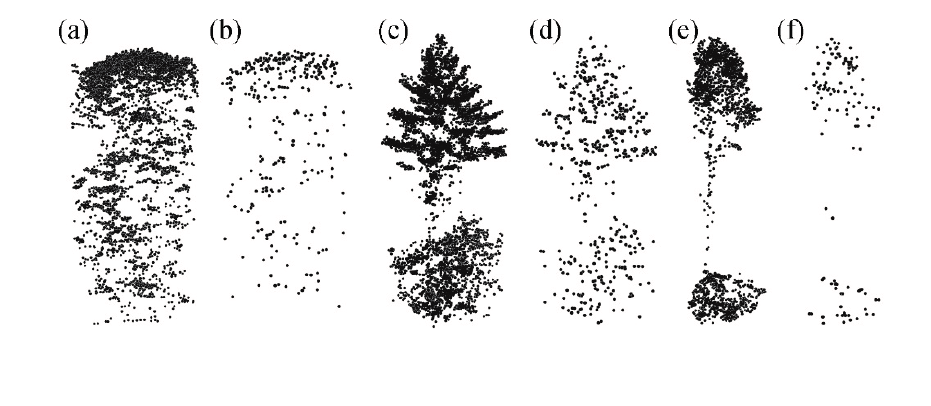
Figure 2. Return distribution examples of maple ( a ) at 40 pulses·m − 2 , maple ( b ) at 1.25 pulses·m − 2 , pine ( c ) at 40 pulses·m − 2 , pine ( d ) at 1.25 pulses·m − 2 , poplar ( e ) trees at 40 pulses·m − 2 and poplar ( f ) trees at 1.25 pulses·m − 2